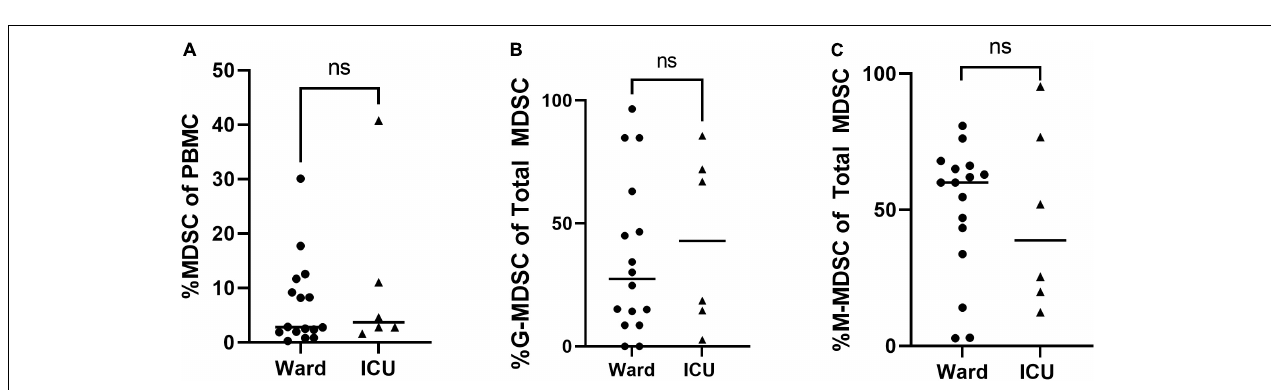
FIGURE 2 | Total MDSC and G- and M-MDSC subsets in children with acute COVID-19 compared to healthy controls and universal screening (Scr) subjects. Children critically ill due to acute COVID-19 had increased proportion of (A) Total (T-) MDSCs and (B) granulocytic (G-) MDSCs compared to those with less severe illness and healthy controls; T-MDSC were also increased in the Scr cohort compared to HC. (C) There was no significant difference in the proportion of monocytic (M)-MDSC between those children admitted to the floor or ICU with symptomatic COVID-19, but children admitted to the ward and in the Scr cohort had an increased proportion of M-MDSC compared to healthy controls. Kruskal-Wallis test was performed, data represent median with IQR. HC ( N = 30), Ward ( N = 18), ICU ( N = 10), Scr ( N = 22). ∗ p -value < 0.05, ∗∗ p -value < 0.01, ∗∗∗ p -value < 0.001, ∗∗∗∗ p -value < 0.0001.